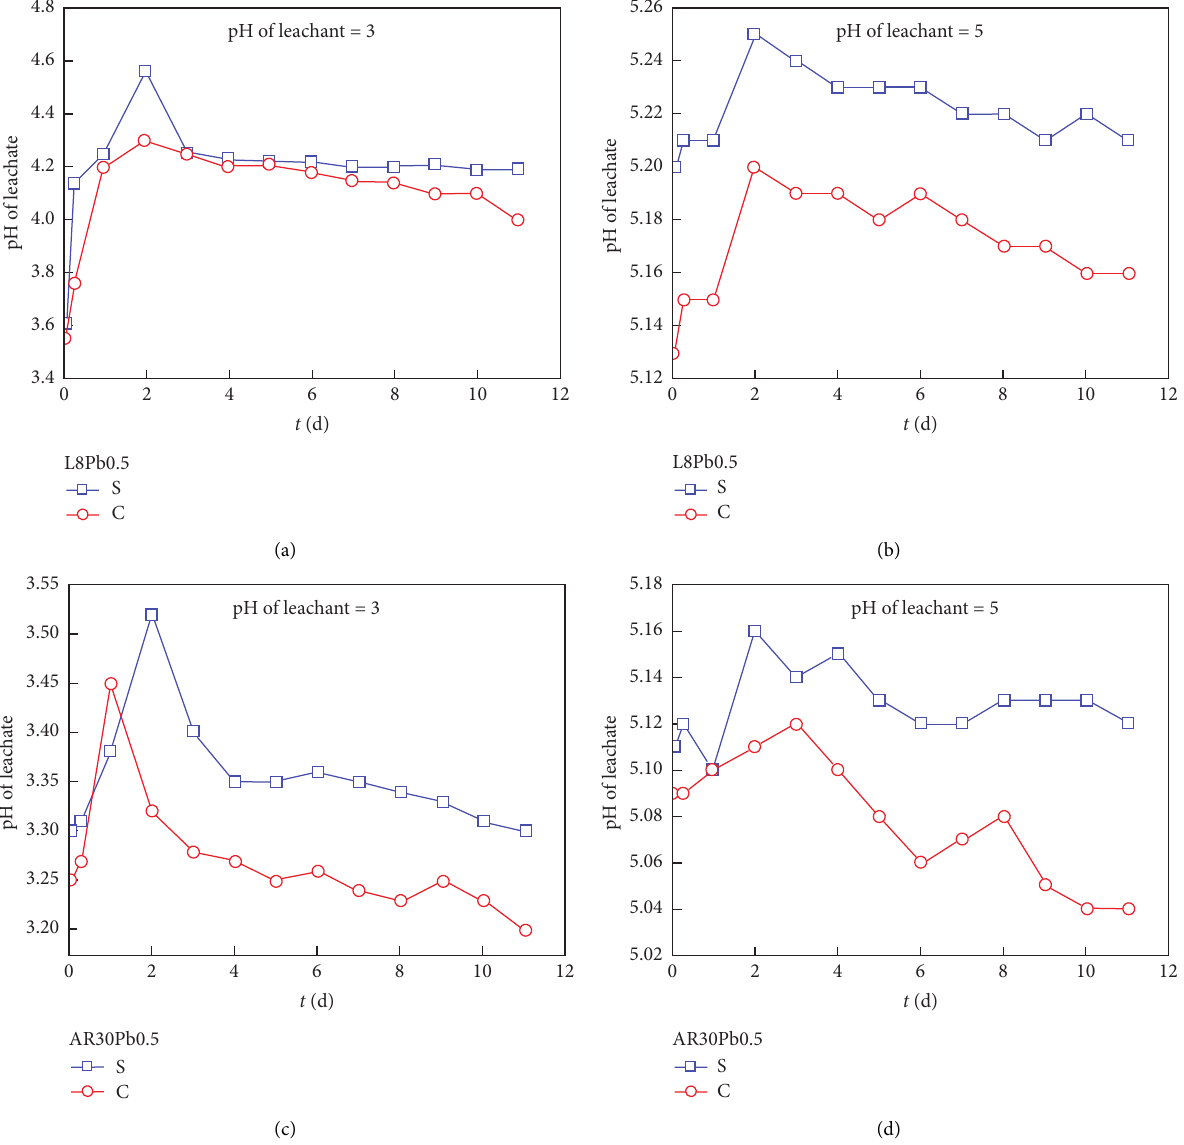
Figure 4: The evolution of leachate pH with leaching time: (a) L8Pb0.5, leachant pH of 3; (b) L8Pb0.5, leachant pH of 5; (c) AR30Pb0.5, leachant pH of 3; (d) AR30Pb0.5, leachant pH of